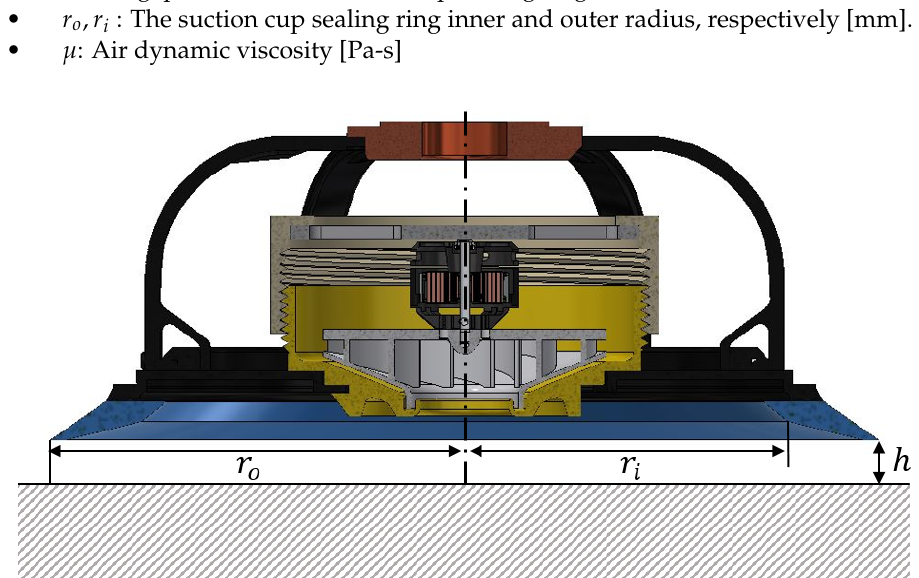
Figure 6. Fluid model of the robot suction